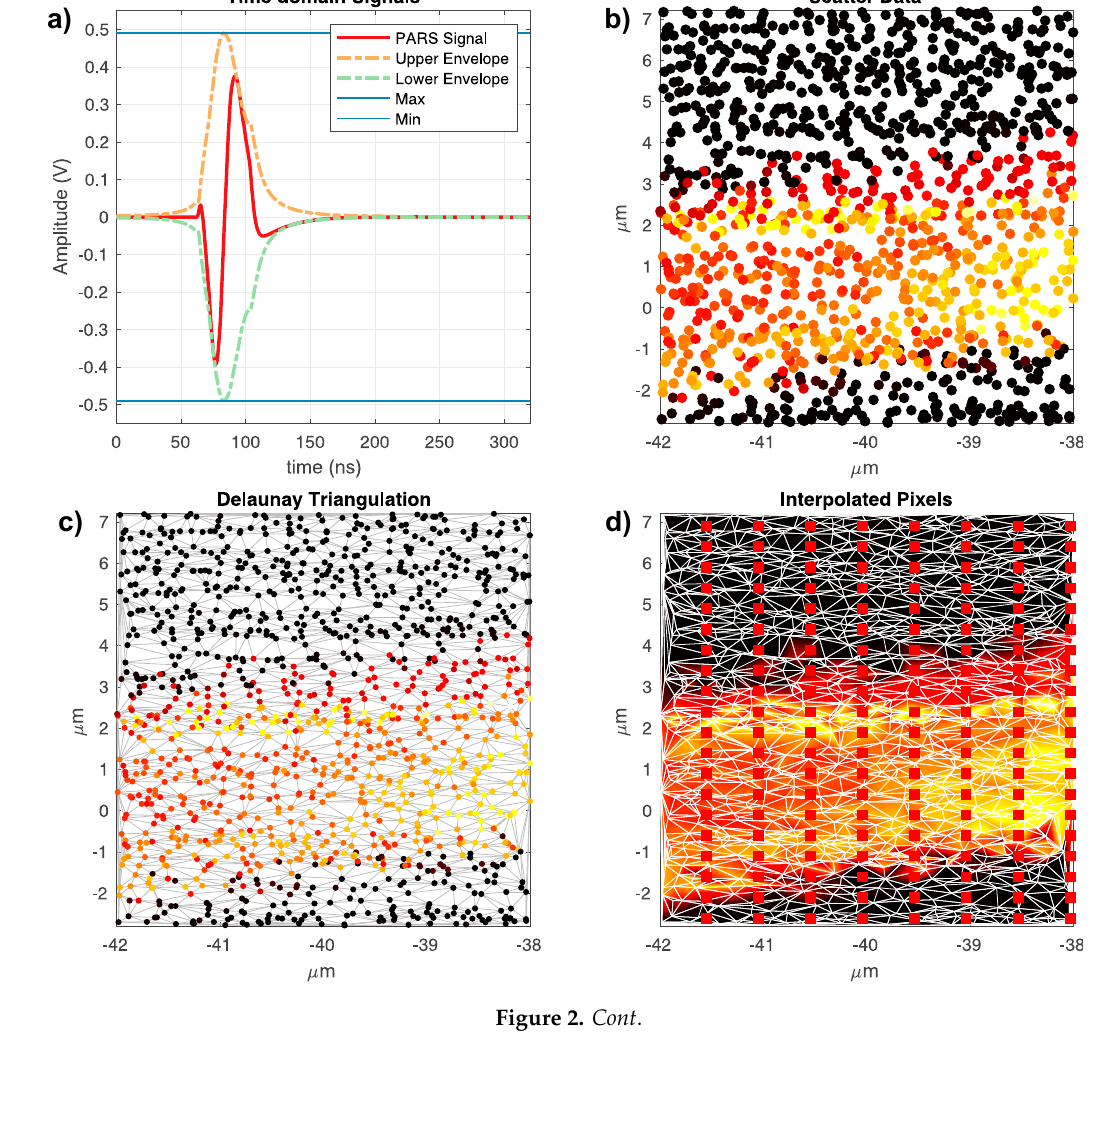
Figure 2. ( a ) PARS time-domain signal with upper and lower envelopes ( b ) raw scatter data ( c ) Delaunay triangulation ( d ) cartesian grid imposed on Delaunay triangulation ( e ) close up of interpolated pixels ( f ) reconstructed image. Using linear interpolation, the intensity at each Cartesian point is then computed from the resulting triangulation. This results in a rendered image, as shown in Figure 2f. The Grid/Stitching plugin in Fiji software is used to assemble all the mosaics presented in this study [23]. This plug-in computes a correlation between the overlapping regions to calculate the best